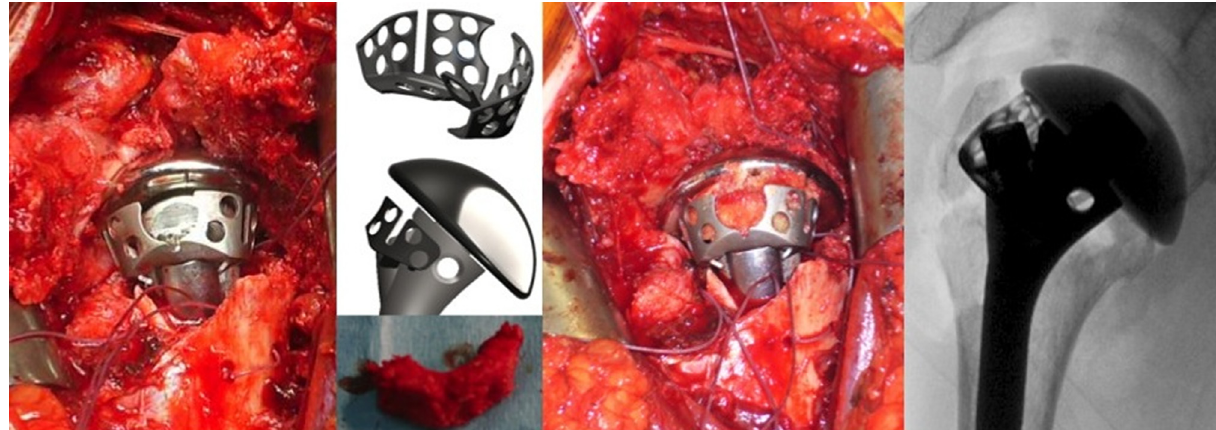
Figure 3. From left to right: The implant is positioned as well as the ‘‘cage’’ (Offset Modular System OMS (cid:4) ), an arched monobloc graft, sized to fit the humeral head, will be set inside the cage which is sufficiently soft to be molded, and sufficiently rigid to prevent medialization of the